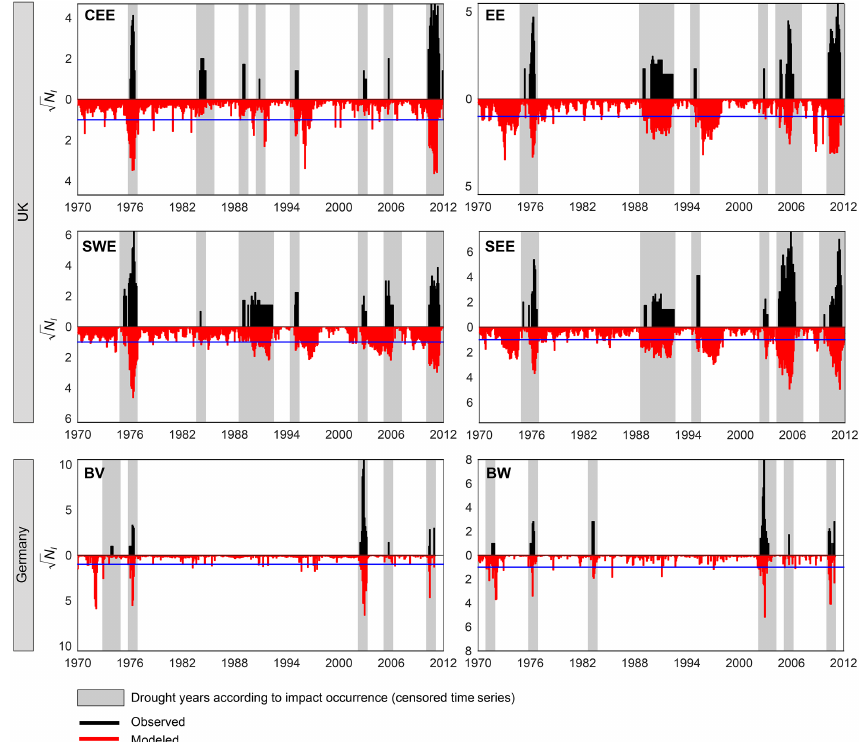
Figure 12. Time series of observed and modeled number of impact occurrences for a selection of NUTS1 regions in the UK and Germany (transformed variables). Gray background: RF predictions; white background: RF backwards learning. The blue line indicates an impact threshold of 1: modeled impacts smaller than 1 should be regarded as absent